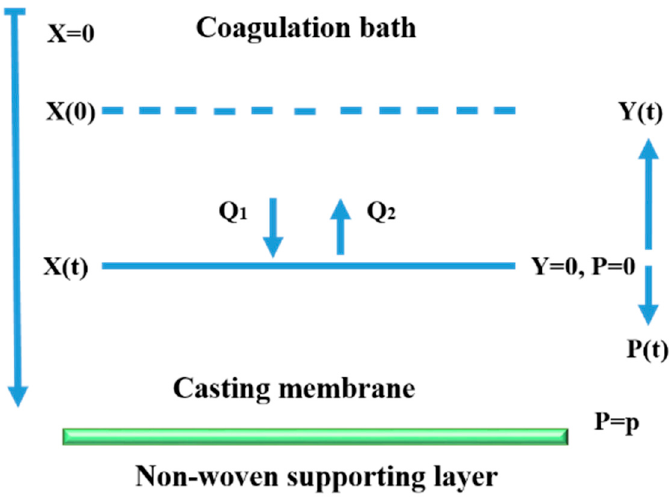
Figure 3. Phase inversion immersion precipitation.